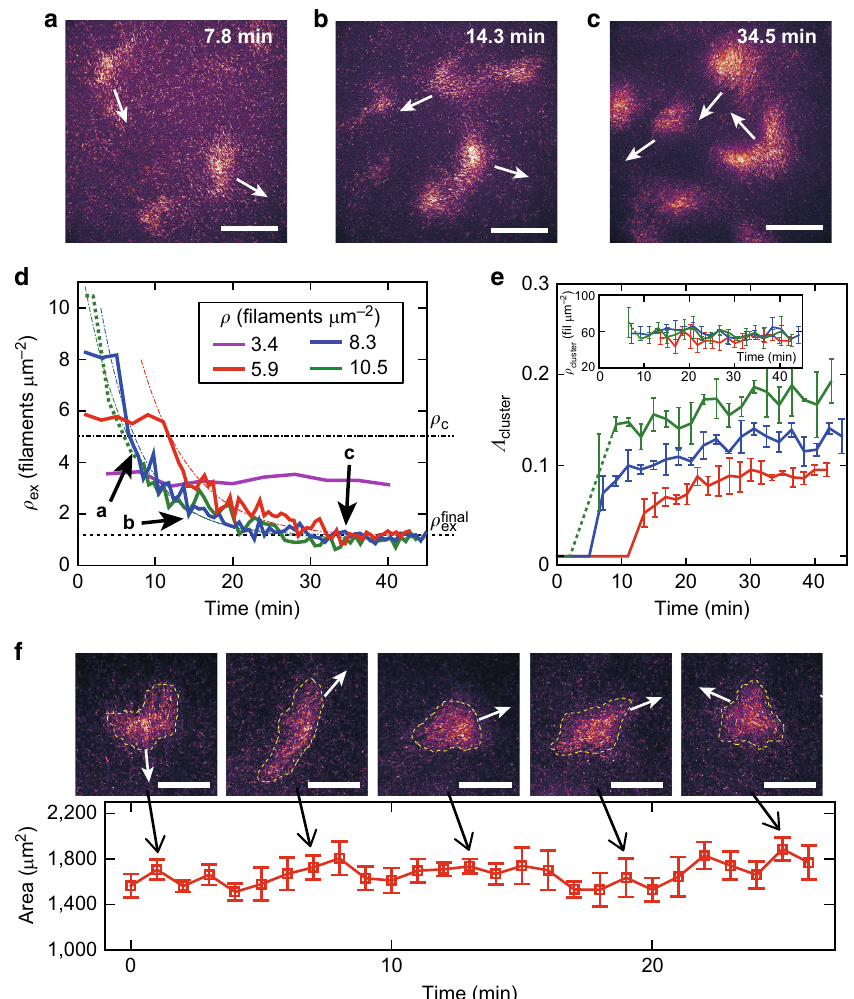
Fig. 3 Dynamics of cluster formation. a – c Time trace of cluster formation for cluster density ρ ≈ 8.3 fi laments μ m − 2 . White arrows depict direction of motion for the clusters. a 7.8 min, b 14.3 min and c 34.5 min after initiation of the actin fi lament motion due to the addition of ATP, as is also indicated in d . Scale bars are 100 μ m. d Dynamics of fi lament density outside clusters for different initial fi lament densities. The dashed line indicates a fi nal fi lament density outside the clusters ρ final . The dash-dot line is the critical density for order – disorder transition ρ c . The dotted line for ρ ≈ 10.5 fi laments μ m − 2 indicates a ex / exp (cid:3) 0 : 15 t ð Þþ 1 : 12, ρ 8 : 3 / transient density-wave regime. The dash-dot lines on top of the data correspond to an exponential fi t, where ρ 5 : 9 ex ex exp (cid:3) 0 : 19 t ð Þþ 1 : 18 and ρ 10 : 5 ex / exp (cid:3) 0 : 17 t ð Þþ 1 : 07. Here, t denotes time. Both the decay tendencies and ρ final ex are similar for all conditions. However, the onset times for the emergence of distinctive clusters are dependent on the initial fi lament density ρ . e Fraction of cluster occupied area Λ cluster . Inset: Filament density inside the cluster ρ cluster , calculated using the experimentally obtained Λ cluster and assuming the conservation of total number of fi laments. Independent of the initial fi lament density ρ , the clusters have a similar fi lament density. Same colours as in d Error bars: s.d. f Area of an individual cluster over time. The constant area over time, along with the constant density of cluster occupied areas demonstrates that with increase in initial fi lament density ρ , the system must increase the number of clusters to sustain the ordered cluster phase. Time 0 corresponds to when the cluster was evidently formed and observable. Filament density condition ρ ≈ 5.7 fi laments μ m − 2 . Broken yellow lines show the outline of clusters. Error bars: s.d. within bin, where a bin of 1 min contains 30 images. Scale bars: 50 μ observable decay of the outside density depends on the starting the density of unlabelled fi laments and ρ label is the density of concentrations and takes longer time for the system with fewer labelled fi laments which is kept constant. This rescaling enables fi laments. This delay time to show the fi rst detectable polar the comparison between the different fi lament density conditions, ordered structures is ≈ 13, 6.5 and 4 min for the starting where the fi lament density outside the cluster is ρ ex = ρ label · γ label . concentrations of 5.9, 8.3 and 10.5 fi laments μ m − 2 , respectively The critical fi lament density ρ c for the order – disorder − 2 21 , thus the lowest studied fi lament transition is 5 fi laments μ m (Fig. 3d). Before the decay of the outside concentration is density condition remains in the isotropic disordered state, while observed, the spontaneously formed clusters are unstable and all other conditions develop an ordered cluster phase. For frequently annihilate. Once a few stable clusters of suf fi cient size the latter conditions with ρ > ρ c , the total fi lament density have assembled, the system proceeds into the ordered phase with outside the cluster ρ ex decays exponentially with a decay time of the same time constant for all systems. This observed dependence τ = 1/ λ ~5.88 min (decay rate λ ~ 0.17(1/min)) to a common value of the delay time on the fi lament density is an indication that a (Fig. 3d), where ρ final is a factor of 5 below the critical nucleation and growth mechanism reminiscent of classical seeding ex concentration ρ c . In spite of these similarities, the onset of the processes is a prerequisite for the order transition to occur.